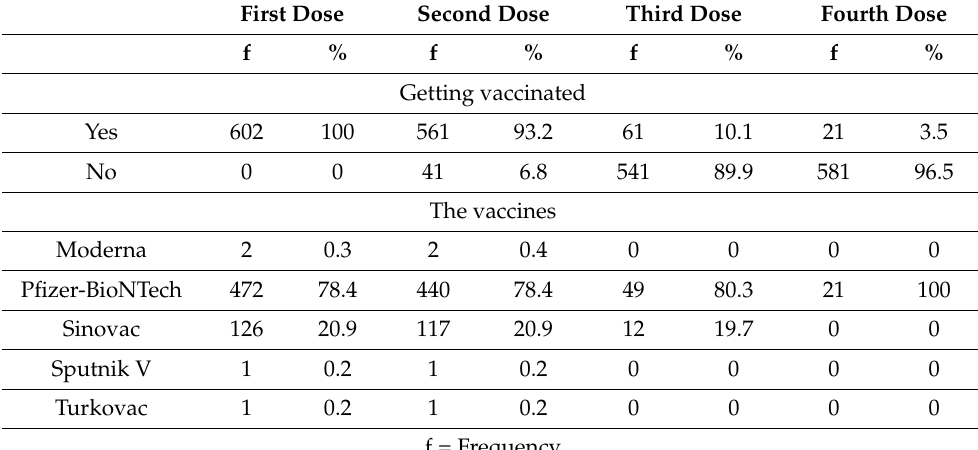
Table 3. Vaccination rates and types of vaccines.